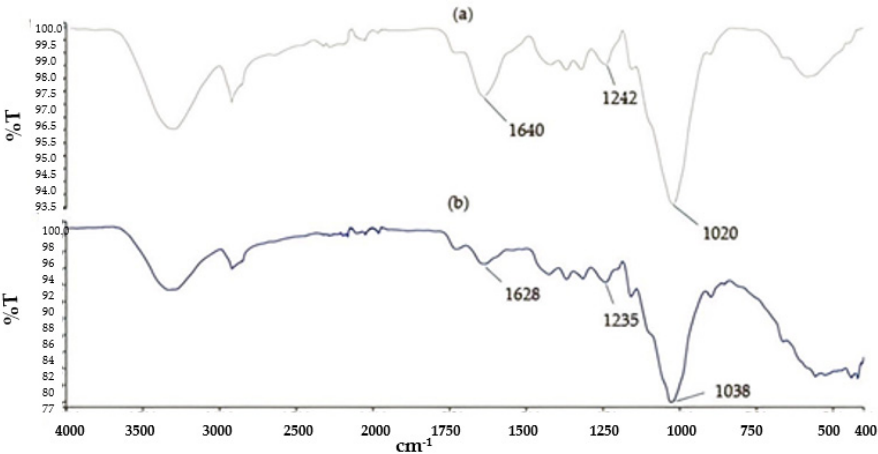
Figure 9. The comparison of FT–IR spectra between ( a ) N–PPF before adsorption and ( b ) N–PPF after adsorption.